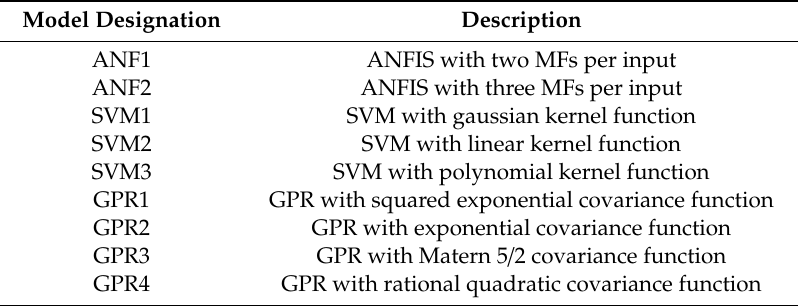
Table 1. Considered prediction